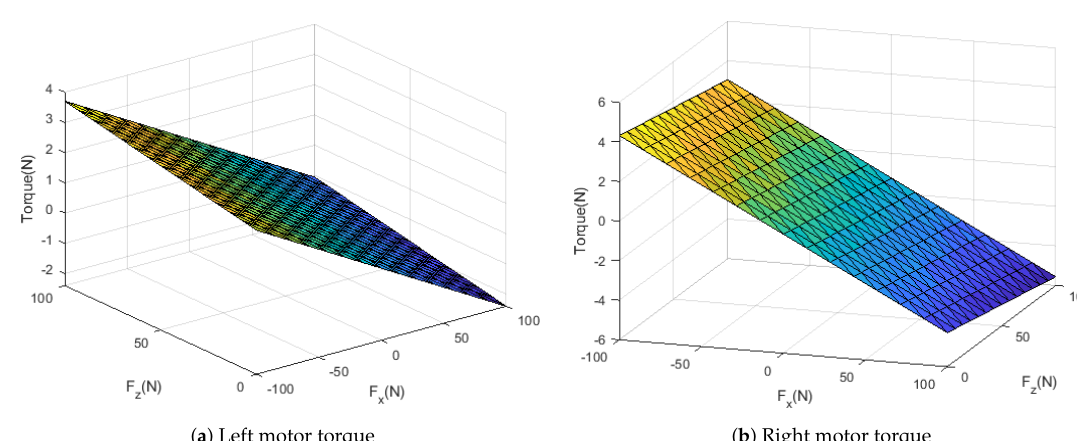
Figure 3. Measured torque is plotted for each force, q 1 = − π